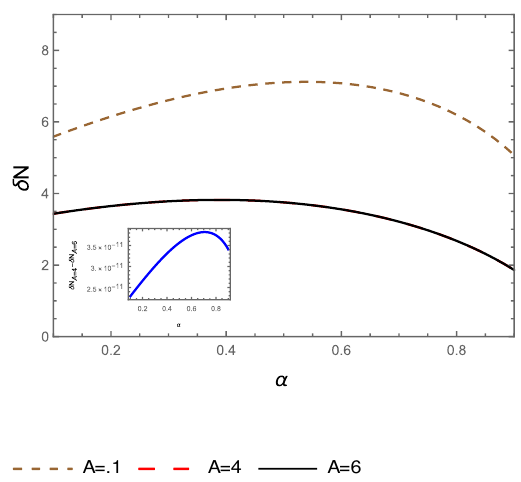
Figure 3 . Parallelly accelerating detectors in (1 + 1) dimensions: δ N VS α plot for different fixed values of A with ∆ E = 1 . Here the two different cases A = 4 and A = 6 are not distinguishable as a B the difference is very